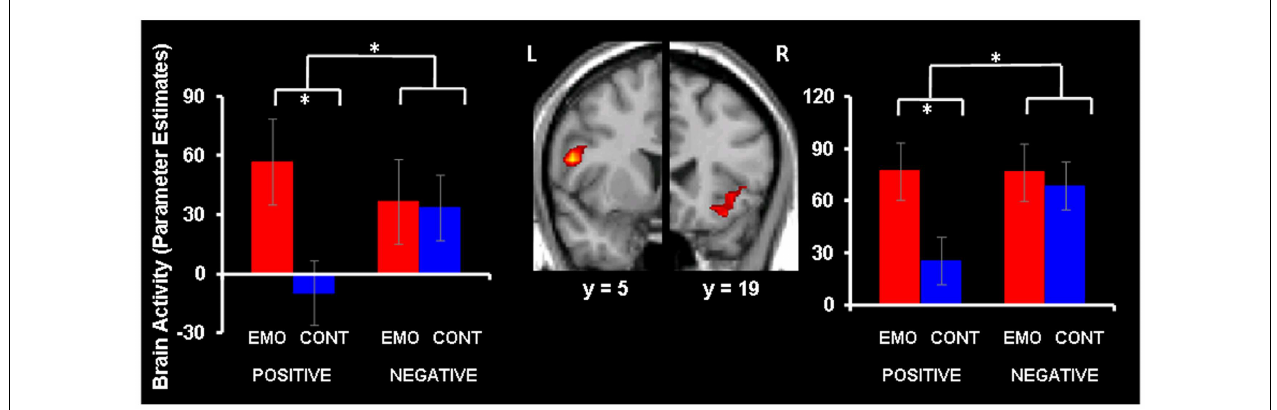
coordinates on the anterior-posterior axis of the brain). For illustration purpose, the interaction map set up at p < 0.05 is inclusively masked with the direct contrast set up at p < 0.05; the effects are also observed when the mask is set up at p < 0.001 ( Table 1 ).The bar graphs represent the contrast estimates extracted from representative voxels in the left and right IFC, respectively.The error bars correspond to the standard errors of the means. L, Left; R,